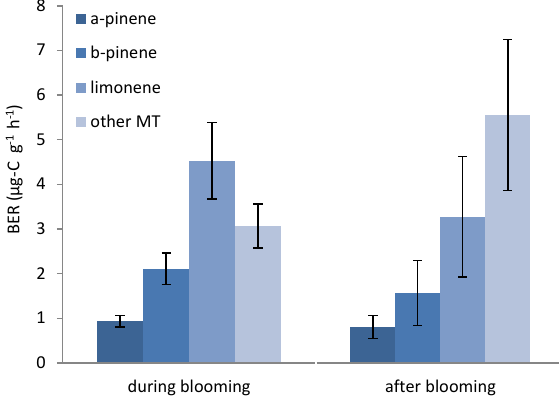
Fig. 7. Average normalized emission rates (30 ◦ C) for α -pinene, β - pinene, limonene, and other monoterpenes from horse chestnut dur- ing and after the blooming period. Error bars represent 95% con- fidence intervals from the averaging of individual results from four experiments.